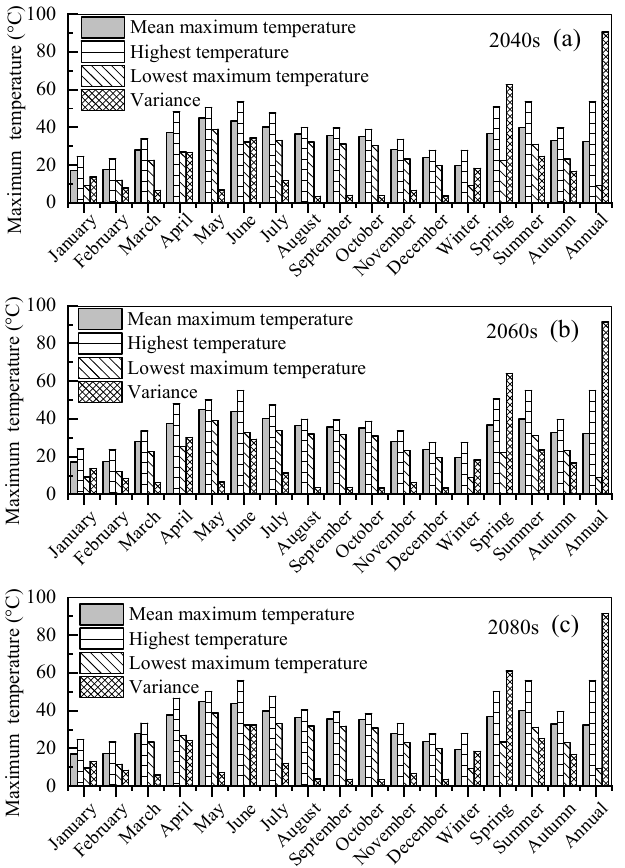
Figure 9. Statics of maximum temperature indices: ( a ) 2040s, ( b ) 2060s, and ( c ) 2080s. Table 3. Soil characteristics and LULC changes from 2000 to